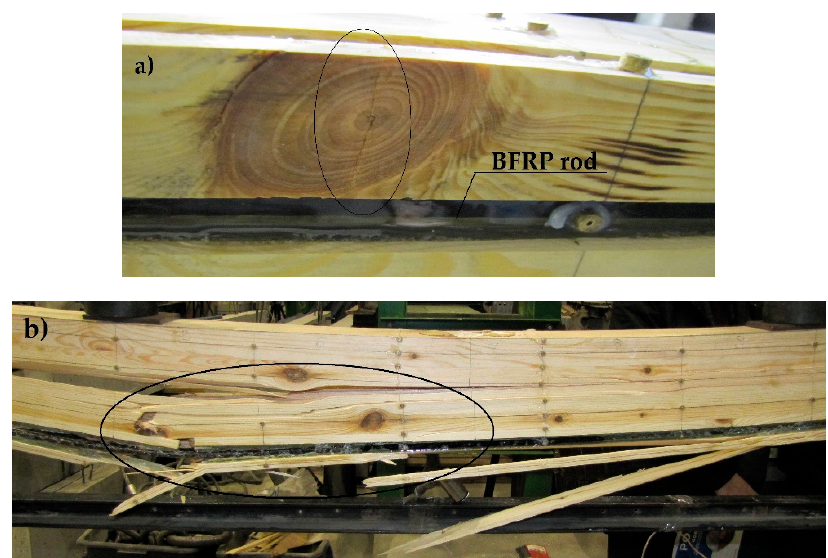
Figure 14. Image of the Wa-B2 beam’s destruction: ( a ) cracking of a deteriorating oval knot, ( b ) cracking of burls near knots and spiral grains (photograph by Wdowiak).